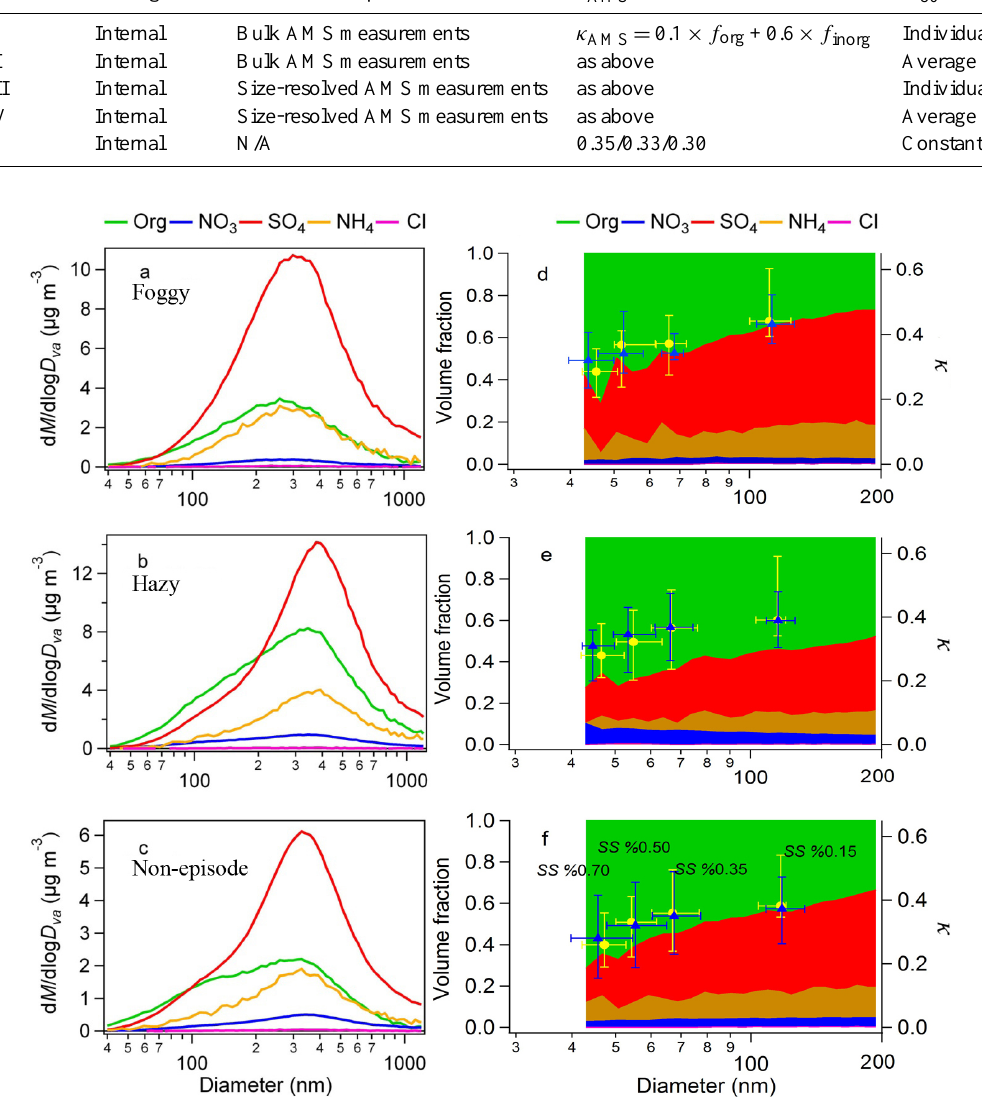
Figure 3. Size-resolved mass concentration distributions of aerosol chemical composition derived from AMS averaged over (a) the foggy period, (b) the hazy period, and (c) the non-episode periods; the corresponding size-resolved volume fractions of aerosol chemical compo- sitions (colored areas), the observed κ CCN (yellow) and the calculated κ AMS_SR (blue) during (d) the foggy period, (e) the hazy period and (g) the non-episode period. Data points median values and interquartile ranges. κ inorg = 0.6 in all cases, κ org = 0.1 in (d) and (f) , κ org = 0.2 in (e)